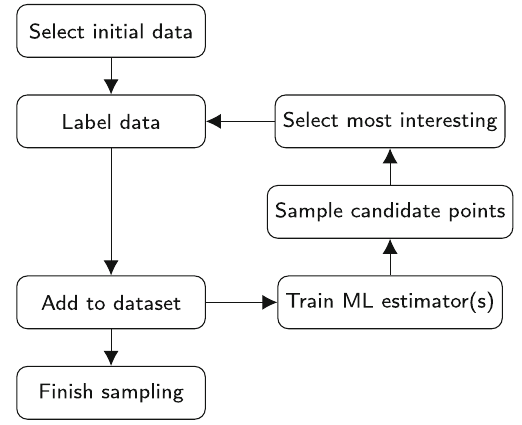
Fig. 2 Diagrammatic representation of active learning. Data is sam- pled and used to create a data set. This data is used to train an ML estimator(oracommitteeofestimators),whichisusedtogetanapprox- imation of the labelling on newly sampled data. From this new data the points with the highest uncertainty in their labelling are selected for sampling via the true sampling procedure and added to the data set. This process can be repeated until enough data is